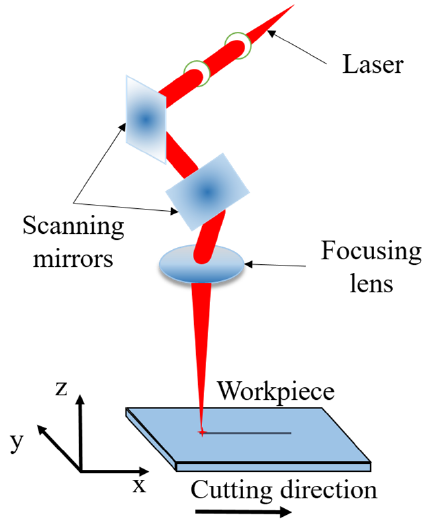
Figure 1. Schematic of the laser cutting of a non-oriented electrical steel sheet.